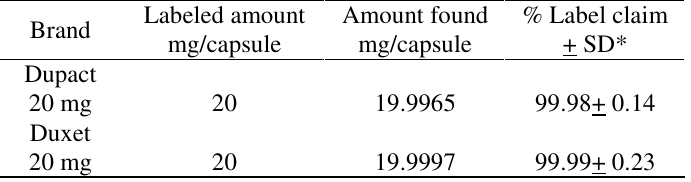
Table 2. Statistical analysis of duloxetine hydrochloride capsules. Labeled amount Amount found Brand mg/capsule mg/capsule